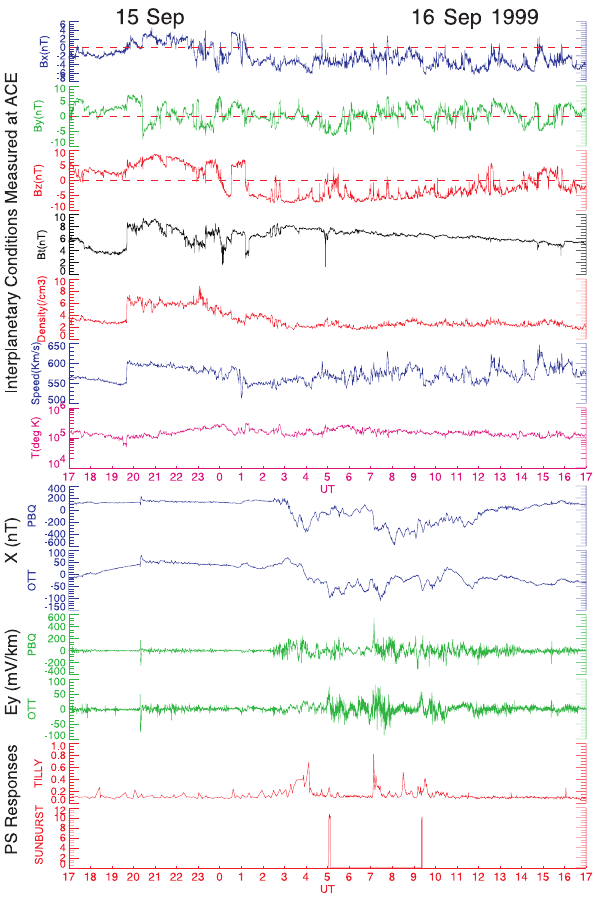
Fig. 5. Same as Fig. 4 except for the 15–16 September